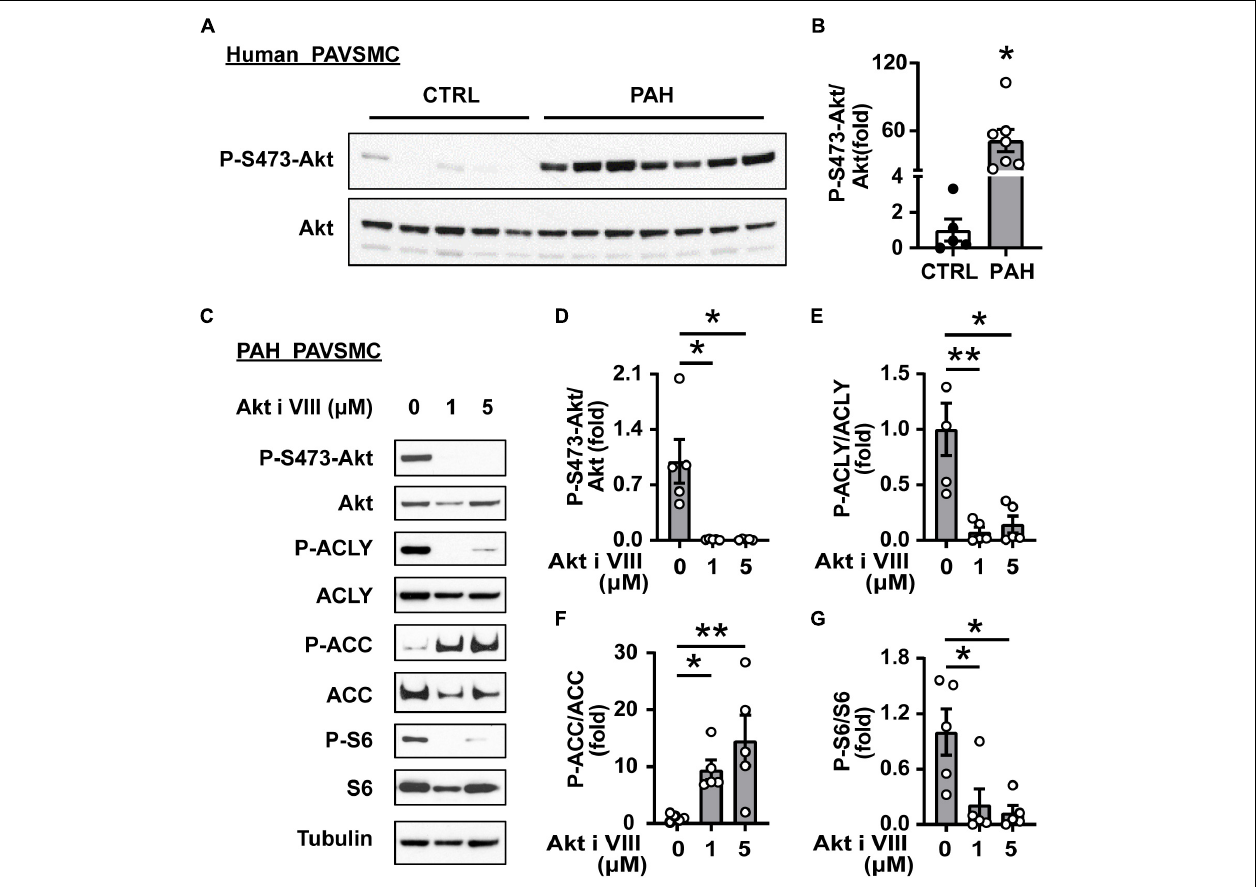
FIGURE 3 | Akt supports ACLY and ACC up-regulation in human PAH PAVSMC. (A,B) Early passage distal human PAVSMC from five non-diseased (CTRL) and seven PAH subjects were serum deprived for 48 h and subjected to immunoblot analysis to detect indicated proteins. Immunoblots (A) and statistical analysis (B) are shown. Data are means ± SE, fold to control, * p < 0.05 by Mann–Whitney U test. (C–G) Early passage human PAH PAVSMC were treated with Akt inhibitor VIII (1, 5 µ M) or vehicle (0) for 24 h followed by immunoblot analysis. Data are fold to vehicle-treated group, n = 5 subjects/group, * p < 0.05, ** p < 0.01 by Kruskal–Wallis rank test with Dunn pairwise comparison post hoc